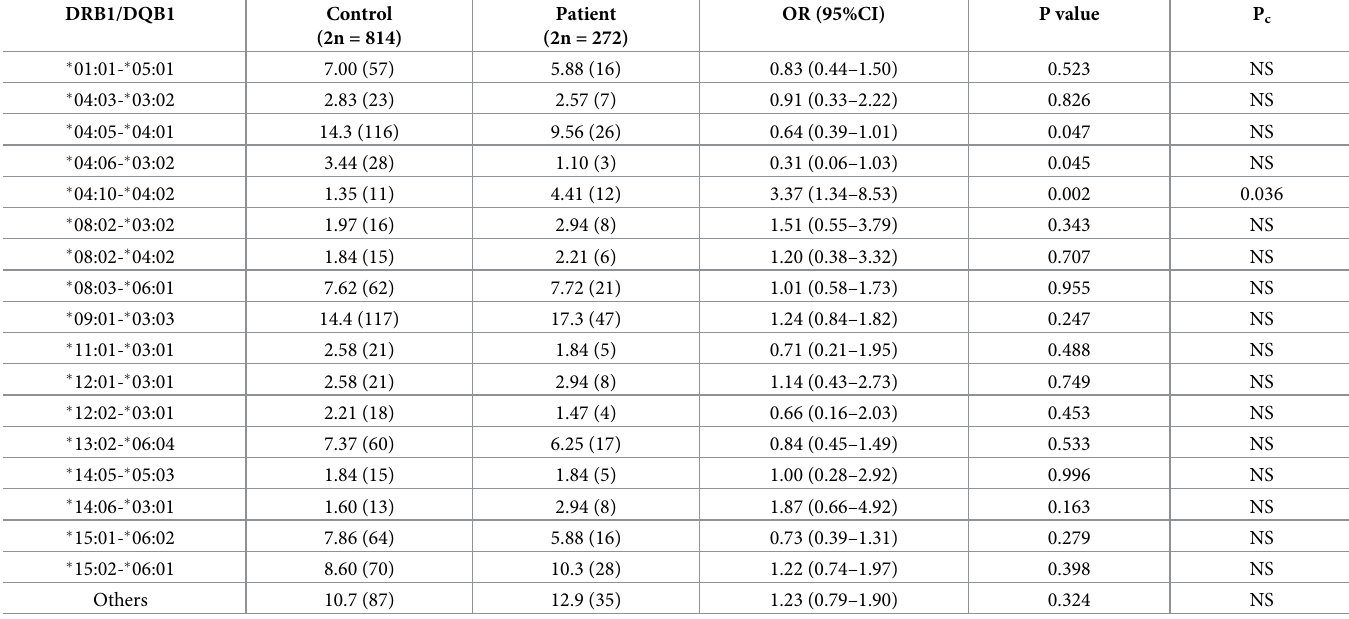
Table 4. Frequencies of estimated HLA-DRB1-DQB1 haplotype carrier in MMD patients and controls. DRB1/DQB1